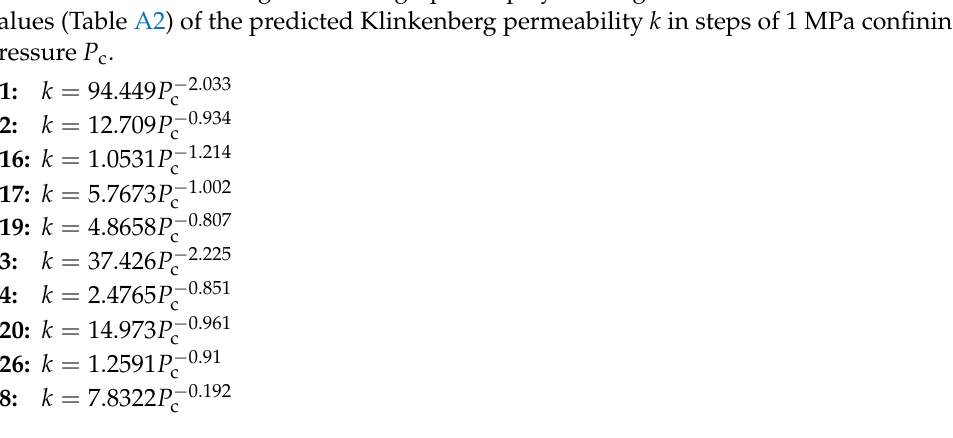
Table A2. Predicted Klinkenberg permeability k in steps of 1 MPa confining pressure P c